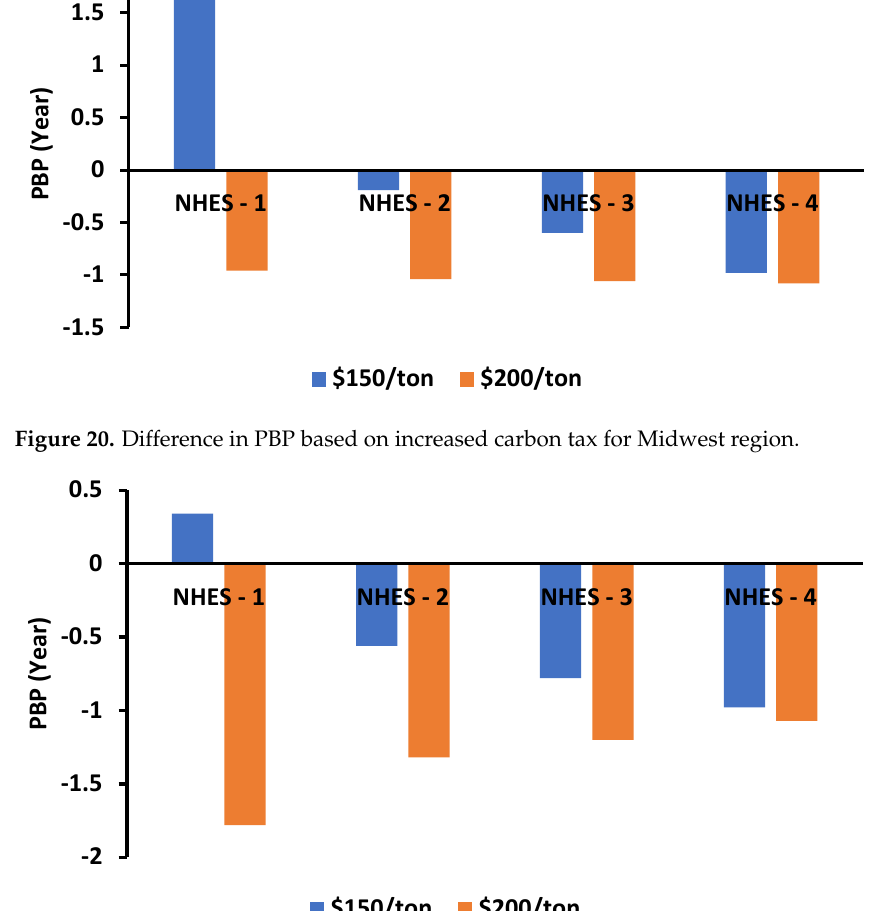
Figure 22. Difference in PBP based on increased carbon tax for Southwest region . The New England and PJM were the two most profitable cases for the NHES-1 sys- tem as per the study described in Section 3.1. Increasing the carbon tax rate has further low- ered the difference in PBP from − 5.6 years to − 7.5 years and − 6 years to − 8.6 years from SMR values for New England and PJM regions, respectively, as shown in Figures 23 and 24.